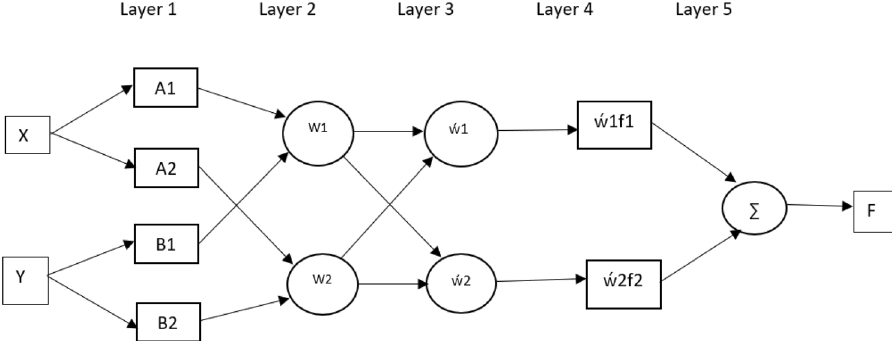
Fig. 1 Typical architecture of ANFIS model